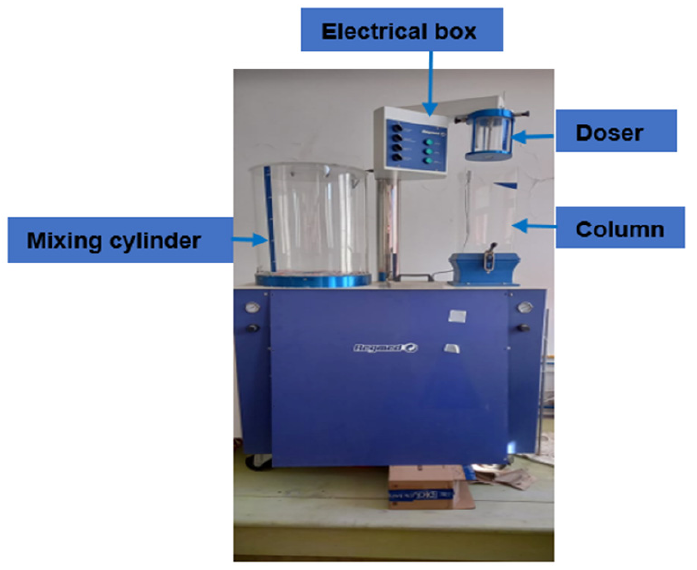
Figure 1. Wet nonwoven machine: Sheet Maker.